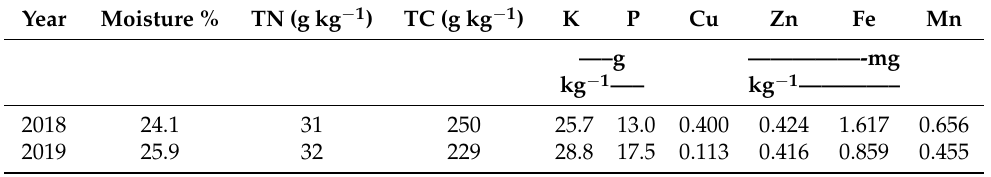
Table 3. Chemical composition of poultry litter applied to the soybean plots at Pontotoc Ridge– Flatwoods Branch Experiment Station, Pontotoc, MS, USA. TN: total nitrogen; TC: total carbon.